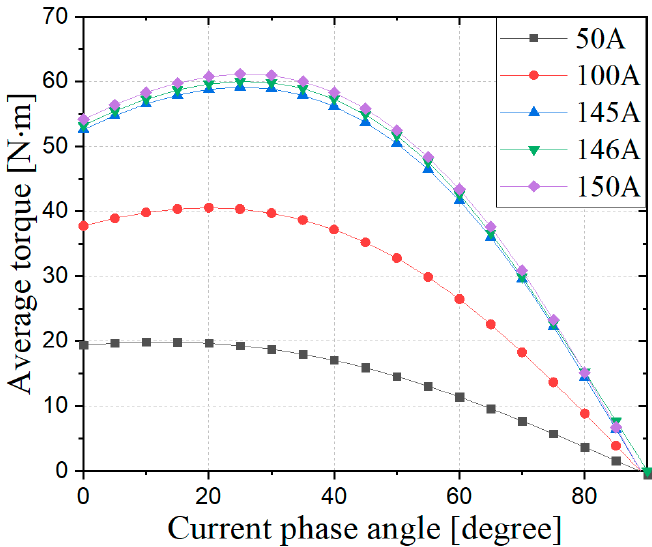
Figure 3. Torque as a function of the changes in current and current phase angle.